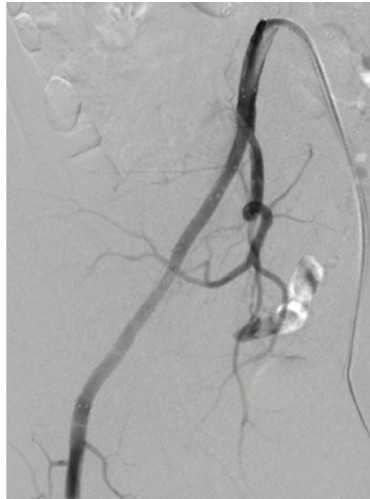
Figure 6: Digital subtraction angiogram, obtained 28 hours after initiation of catheter-directed thrombolysis, shows patency of stented right common and external iliac